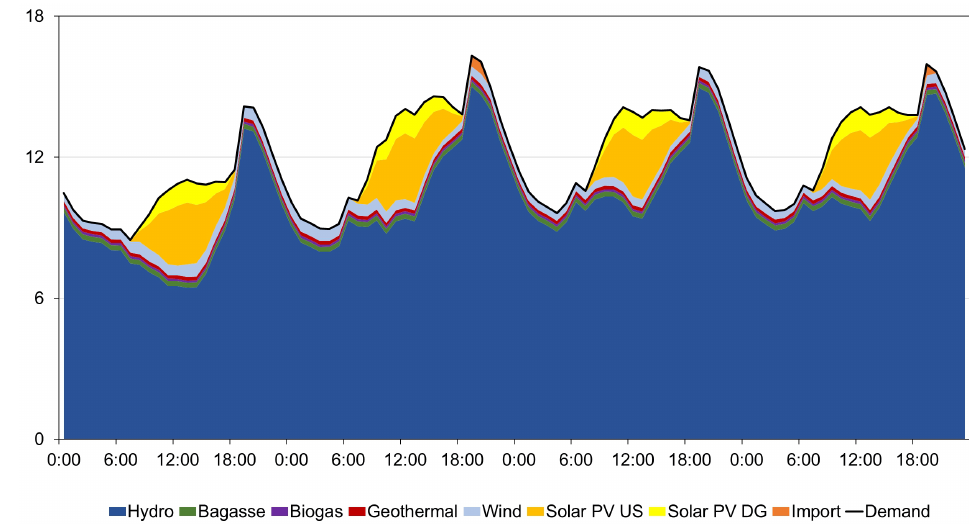
Figure 11. Electricity dispatch per hour in TWh during four days in October 2050 for the DDP